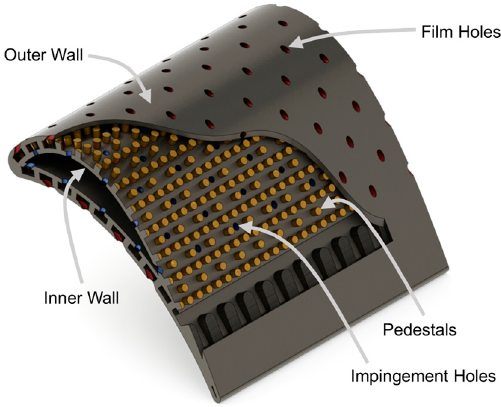
Figure 16. A conceptual design of double-wall cooled turbine blade. Reprinted with permission from [99]. Copyright 2020 ASME.